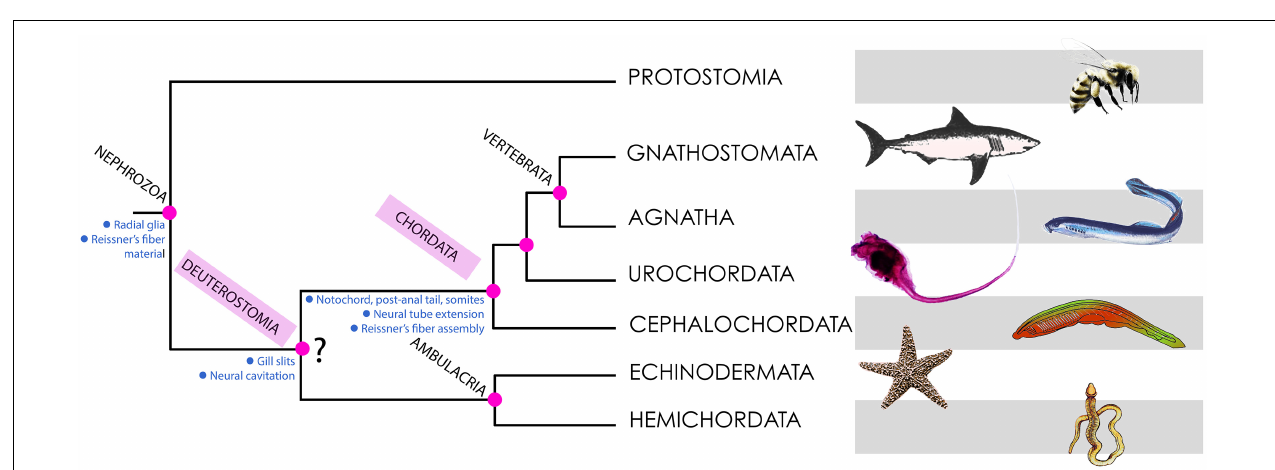
FIGURE 2 | Phylogeny of deuterostomes, indicating the points of origin of the characters discussed in this article. Most phylogenetic analyses place Deuterostomia as a monophyletic group (as depicted here), with Chordata and ambulacria as sister groups. However, some recent findings using large scale genetic databases claim that there is no evidence for Deuterostomia as a monophyletic group (Kapli et al., 2021). Hence the interrogation mark shown at this node. The main conclusions of this article are consistent with both